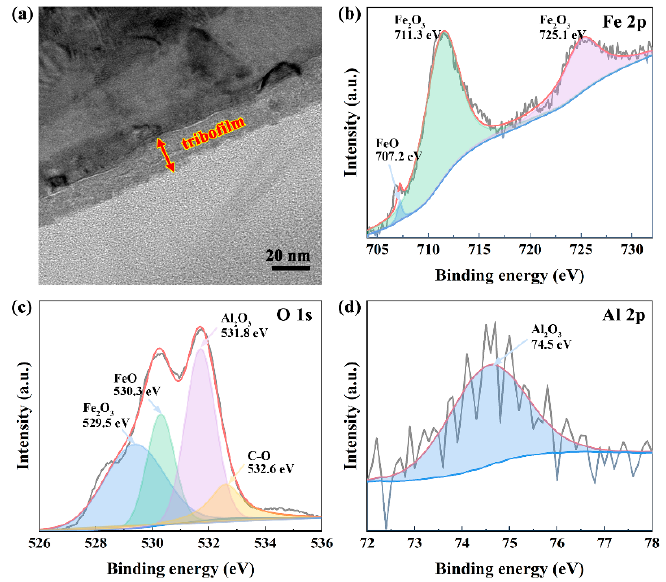
Figure 10. ( a ) TEM image of tribofilm on the worn disk surface, XPS resolved fitting curves of ( b ) Fe 2p, ( c ) O 1s and ( d ) Al 2p spectra of the worn surface lubricated by 0.20 wt.% rGO-Al 2 O 3 nanofluid.